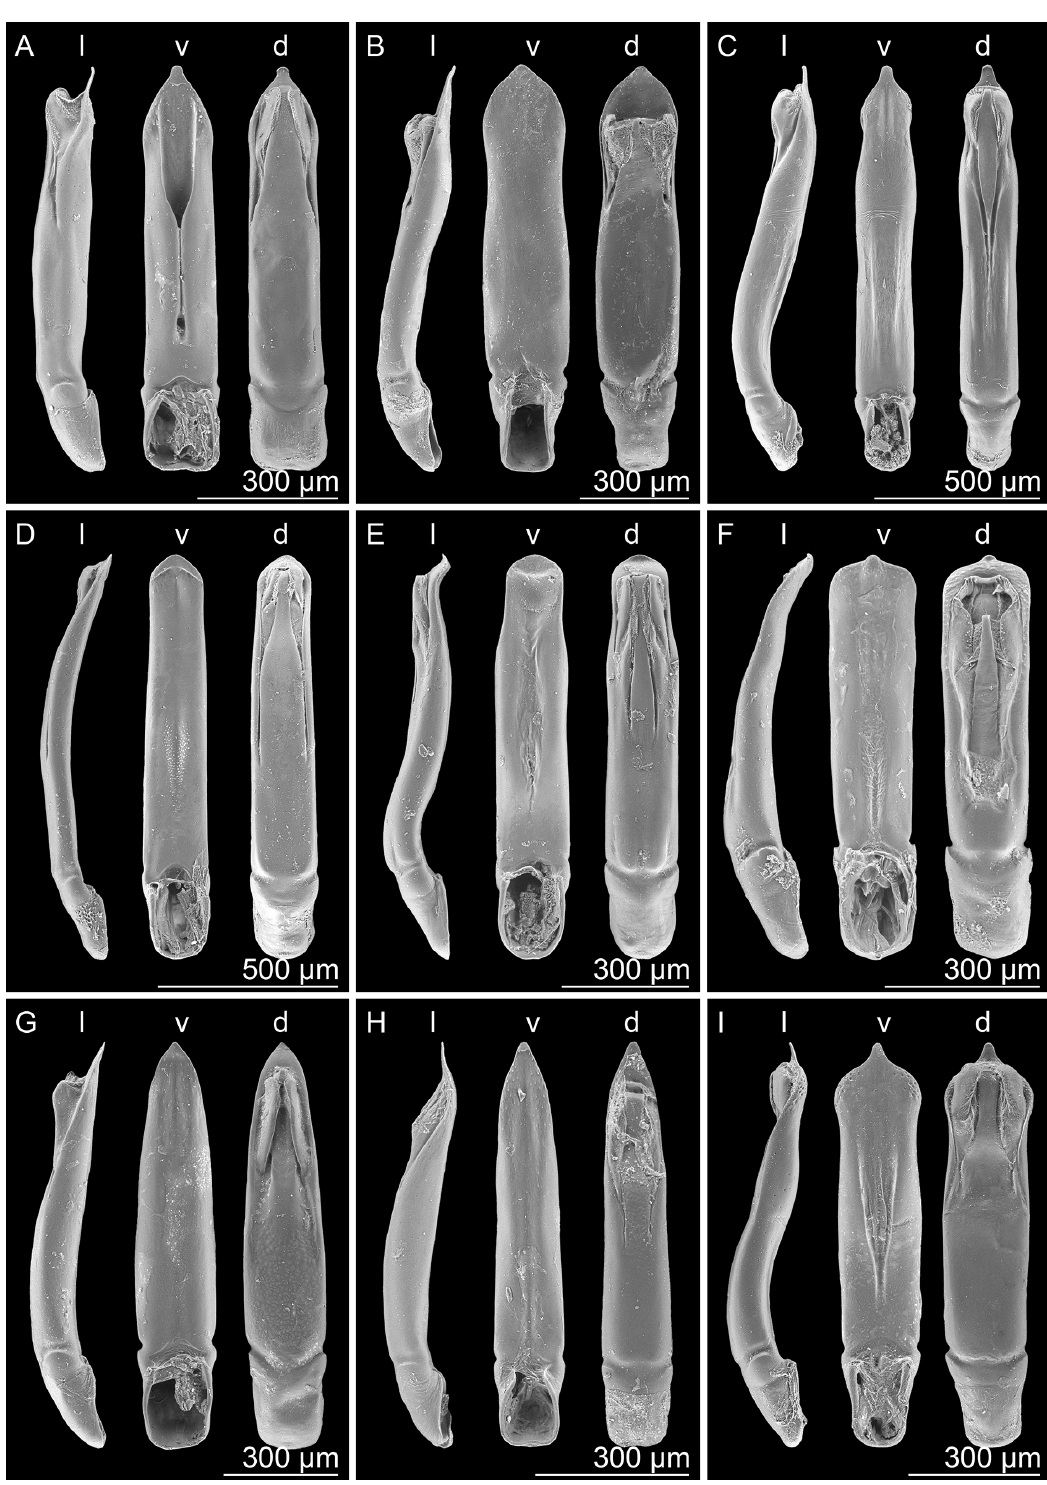
Fig. 9. Median lobe of aedeagus in lateral (l), ventral (v) and dorsal (d) view. A . Arsipoda isola